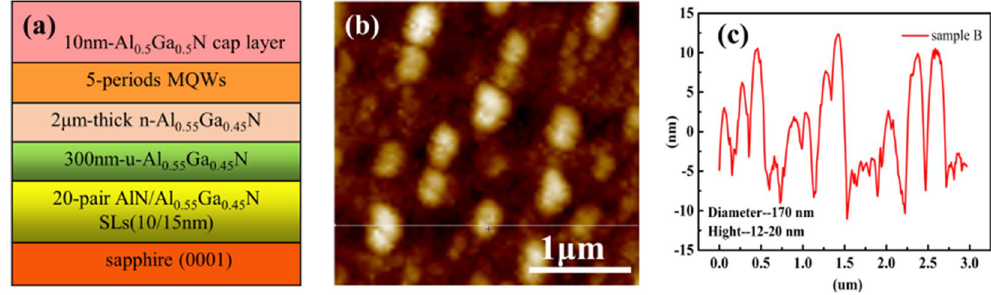
Figure 1. ( a ) Schematic illustration of the structure for sample A; ( b ) Atomic force microscopy (AFM) topographic image of Al particles on AlGaN surface of sample B, which are formed by annealing 30 mins in N 2 ; ( c ) The AFM image of the depth profile along the dashed line in Fig. 1(b).